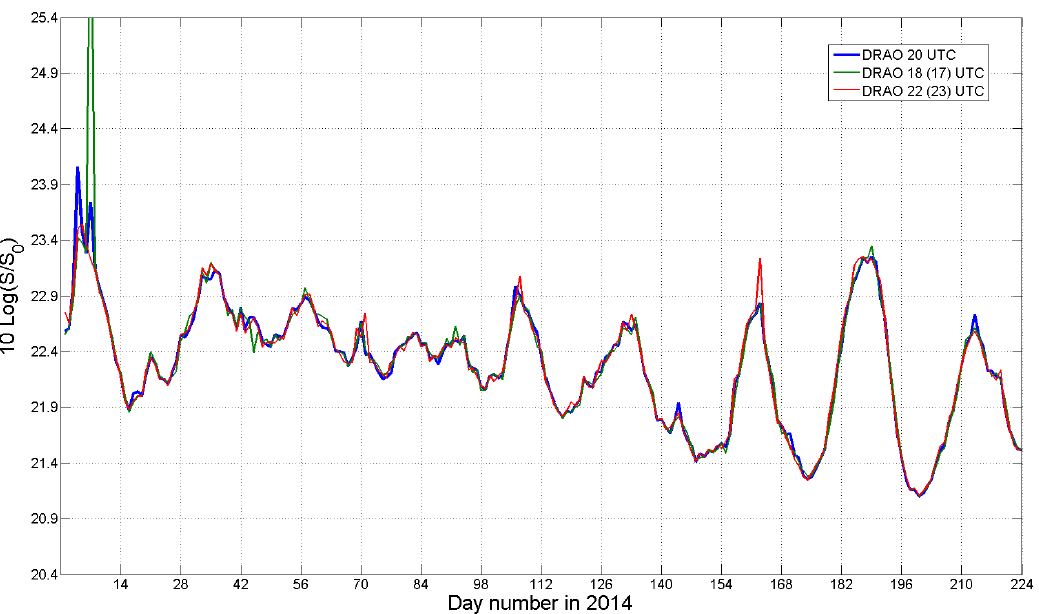
Figure 1. Daily solar flux values measured by the Dominion Radio Astrophysical Observatory (DRAO) in Canada at 10.7 cm and extrapolated to the C-band. Each flux determination takes an hour. Note that S 0 = 1 sfu = 10 −22 W∙m −2 ∙Hz −1 .